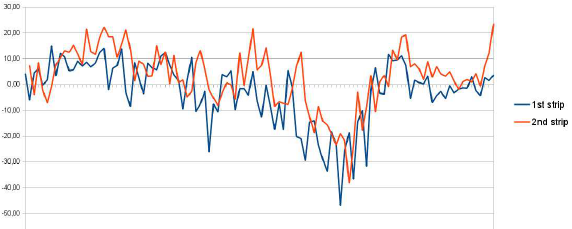
option.Figure 8: Difference between each individual focal length and the average value (in